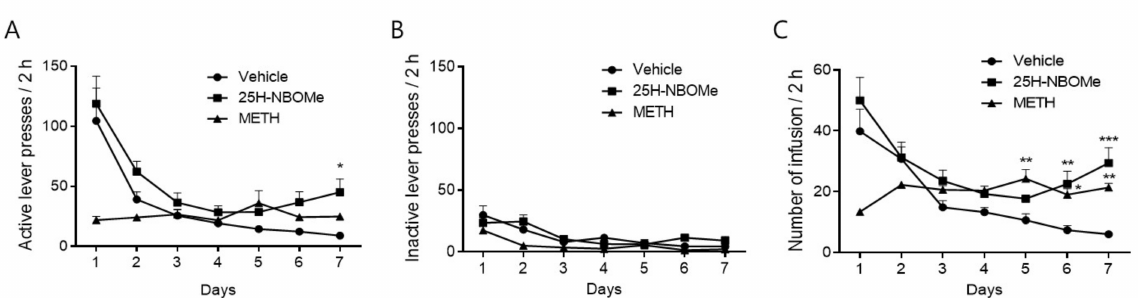
Figure 4. Intravenous self-administration (SA) of 25H-NBOMe and methamphetamine (METH). Data are expressed as the mean number of active lever presses ( A ), inactive lever presses ( B ), and infusion ( C ), following SA of 25H-NBOMe (0.01 mg/kg) and METH (0.1 mg/kg). Data are expressed as mean ± SEM ( n = 8 each group). * p < 0.05, ** p < 0.01, *** p < 0.001 vs. vehicle, determined by a two-way ANOVA followed by Bonferroni’s post-hoc test.